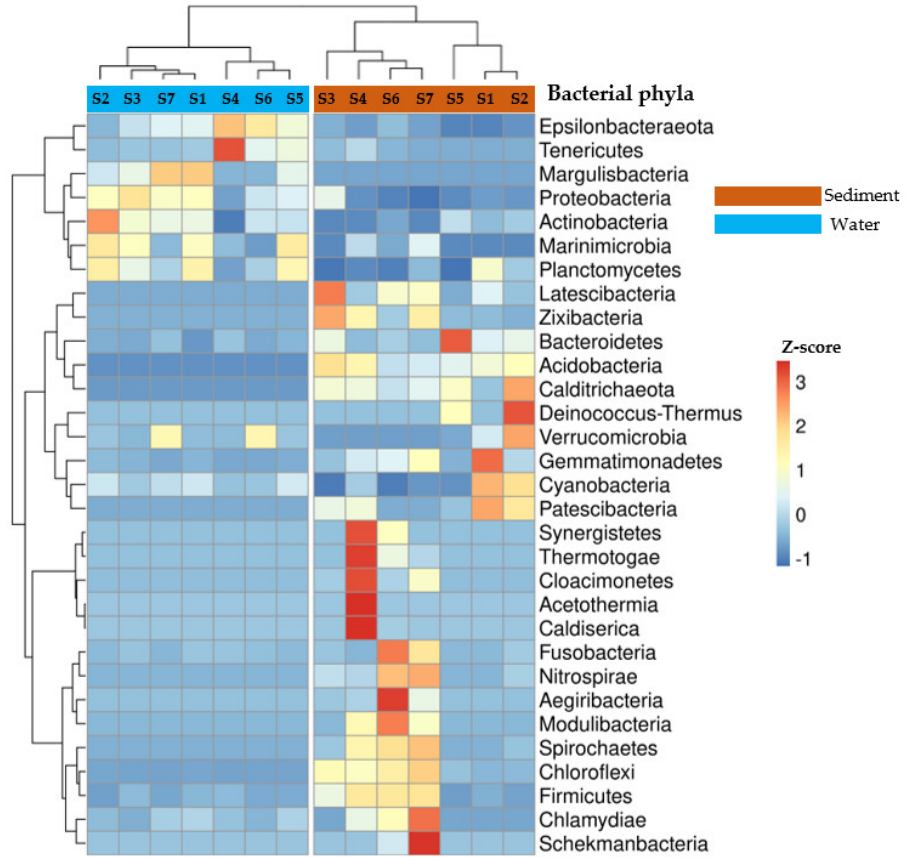
Figure 1. Hierarchical heatmap representing the relative abundance of bacterial communities (at phyla level) in the sediment and water samples of the seven stations (S1–S7). The relative abundance is represented by Z-score (based on the mean and standard-deviation (SD) of Z-scores of each phyla in all samples). The stations and bacterial phyla were clustered using the bray-curtis distance, which is represented by a dendrogram on the top and left side of the graph. Z-scores are scaled according to the relative abundance of bacterial communities. A positive z-score indicates that the value is above average. A z-score of 0 indicates that the value is within the average. A negative z-score indicates that the value is below average.